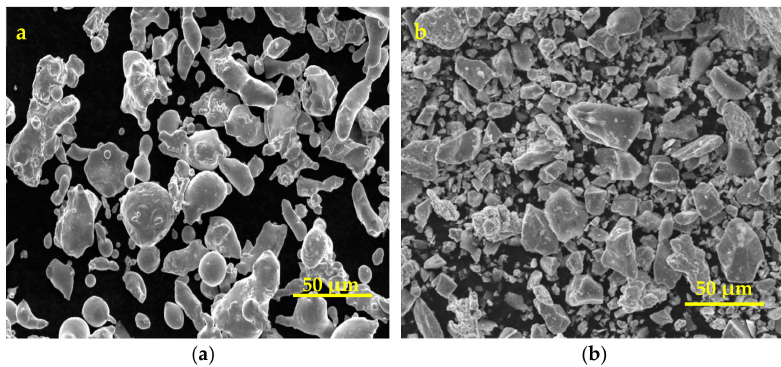
Figure 1. SEM pattern of ( a ) the 304 stainless steel powder and ( b ) the Fe/Mn/Si mixed powder.